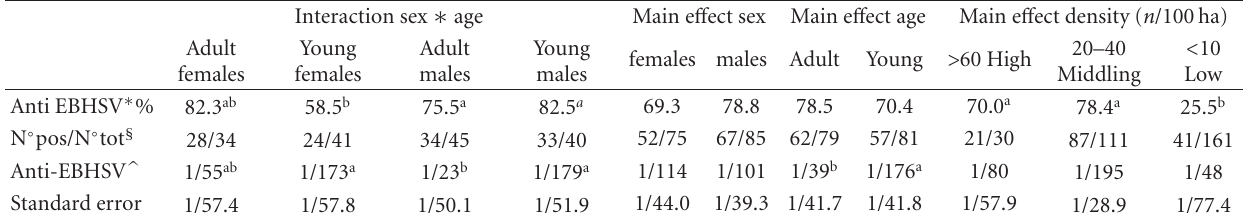
Table 1: Anti-EBHSV antibodies positivity and serological titers in hares in relation to sex, age, sex ∗ age and density.